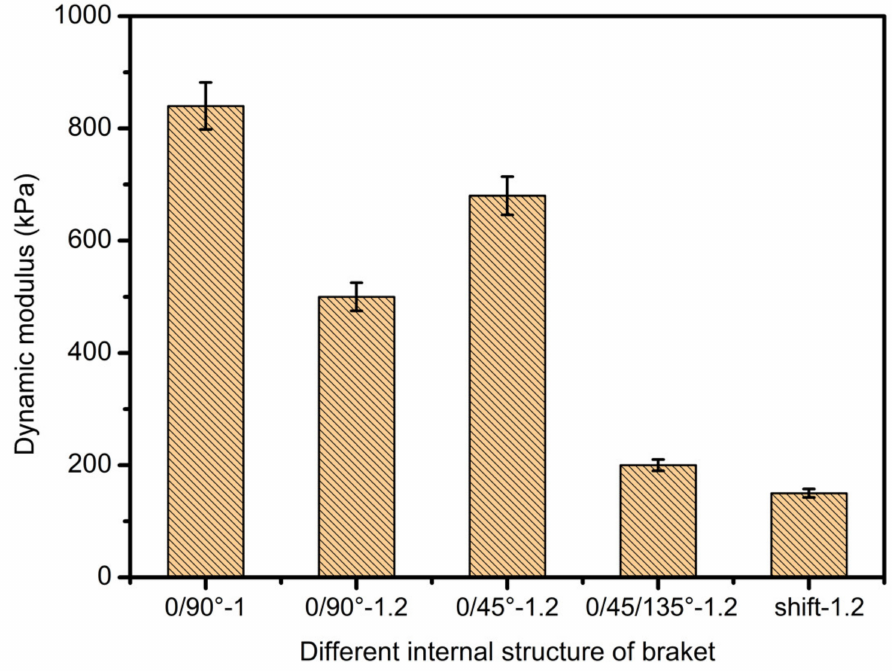
Figure 16. Dynamic modulus diagrams of sca ff olds with di ff erent internal